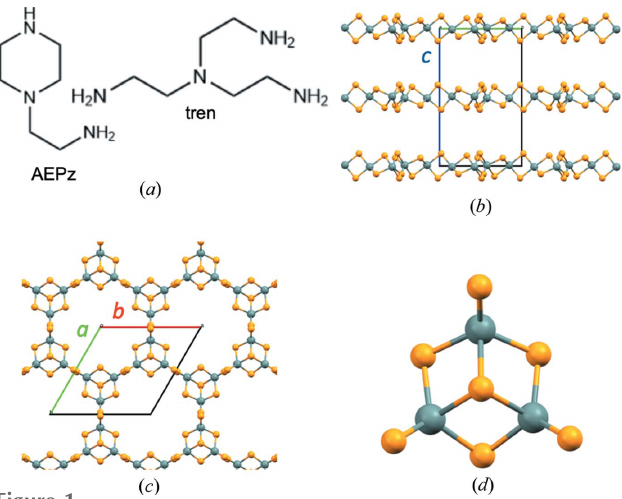
Figure 1 Structures of AEPz-SnS-1 and trenH-SnS-1: ( a ) Molecular structures of AEPz and tren (shown in their unprotonated forms). ( b ) Side-view showing the thiostannate layers stacked along the crystallographic c axis. ( c ) Top-view of a porous thiostannate layer. ( d ) Fundamental building block of the R -SnS-1 structures, i.e. the Sn 3 S 4 broken-cube cluster, which is connected to three neighboring clusters through double sulfur bridges. Sn is shown in gray and sulfur is shown in orange. The structural drawings are based on the single-crystal structure of trenH-SnS-1 (Filsø et al. ,